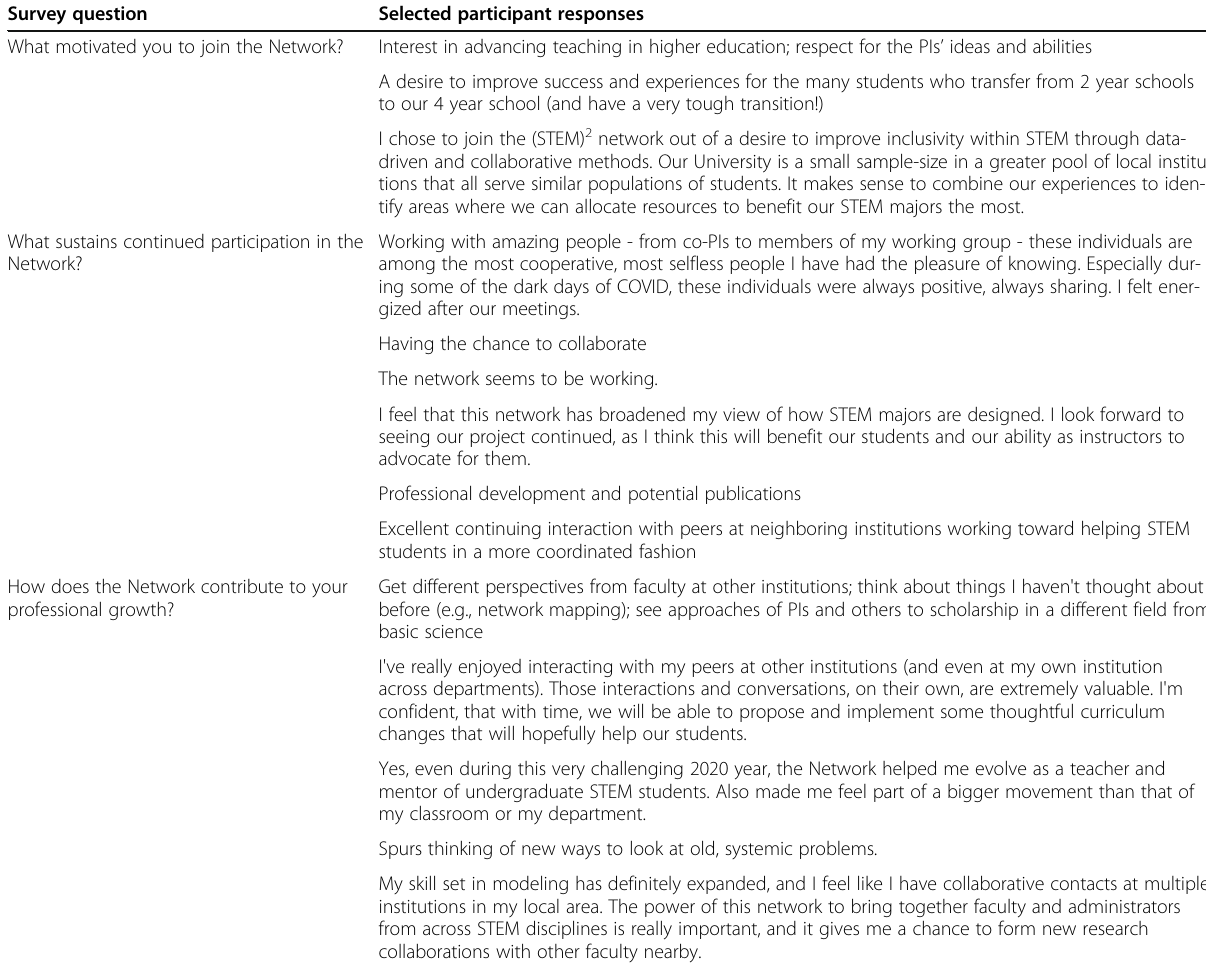
Table 2 Participant responses to survey questions regarding motivations to join the (STEM) 2 Network, and sustained participation in and professional growth resulting from participation in the Network Survey question Selected participant